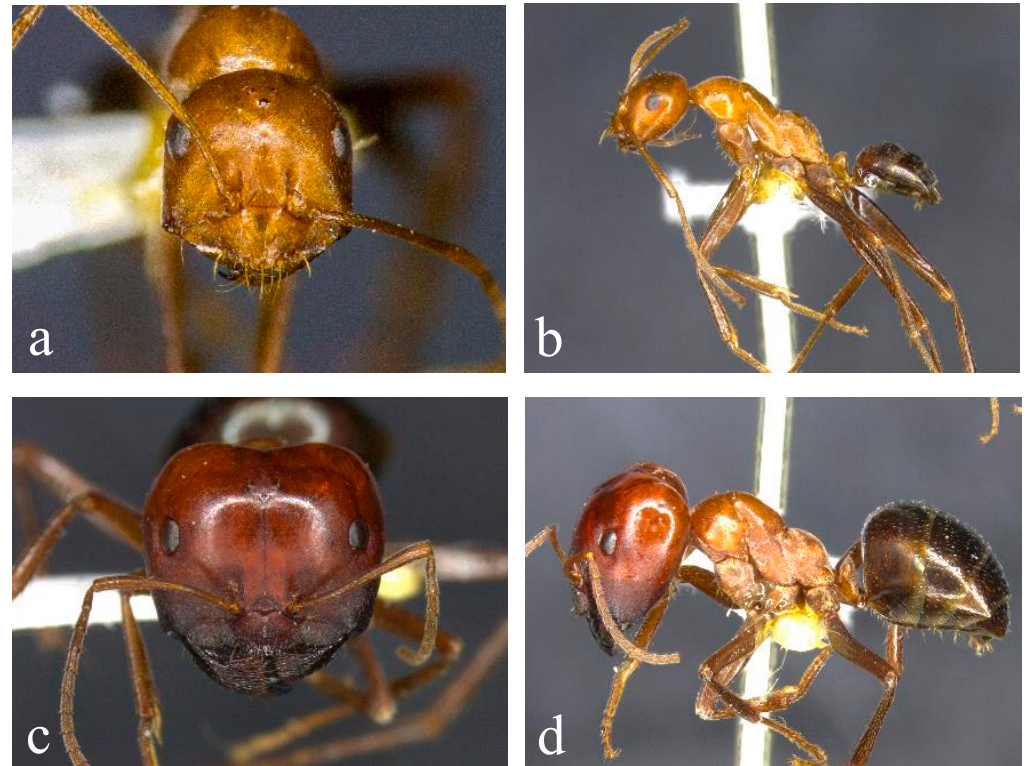
Figure 4. Morphology of sp. 35 from the Melophorus rufoniger complex. Minor ( a , b ) and major ( c , d ) workers of sp. 35 from Kalkarindji, NT (not sequenced).